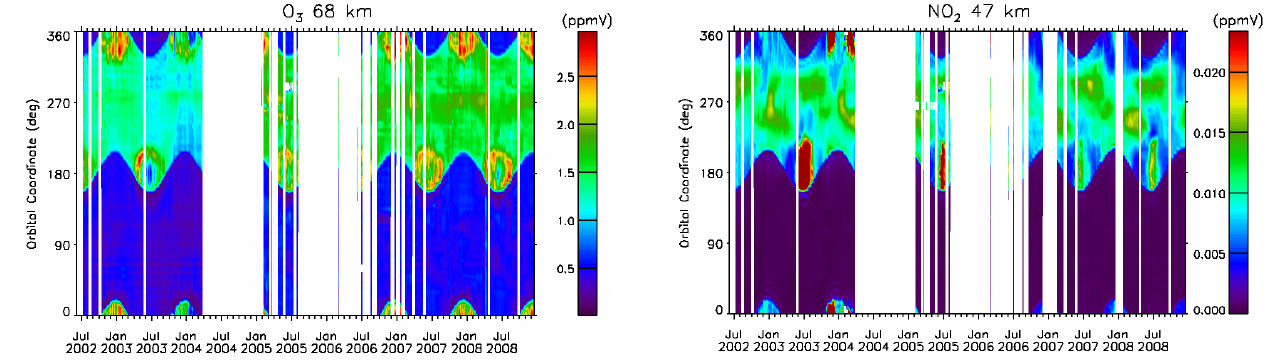
Fig. 11. 5-days mean of O 3 VMR (ppmv) at 68km plotted as a function of the OC and the acquisition time.